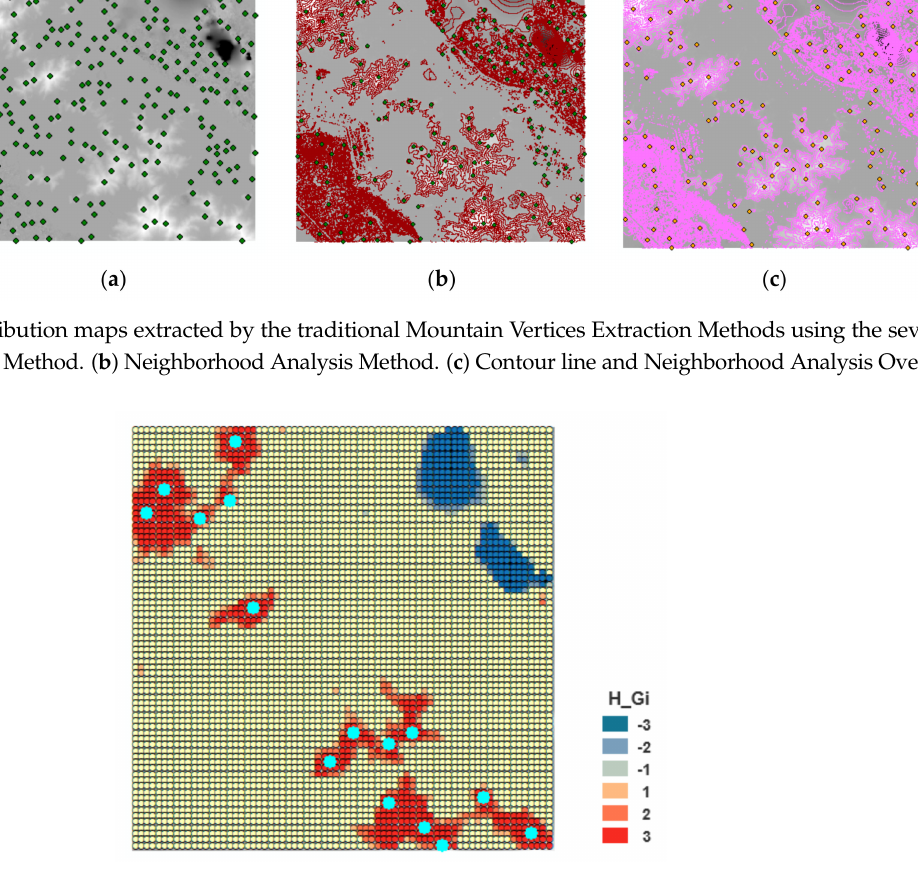
Figure 35. The distribution map for the seventh dataset using our proposed approach.